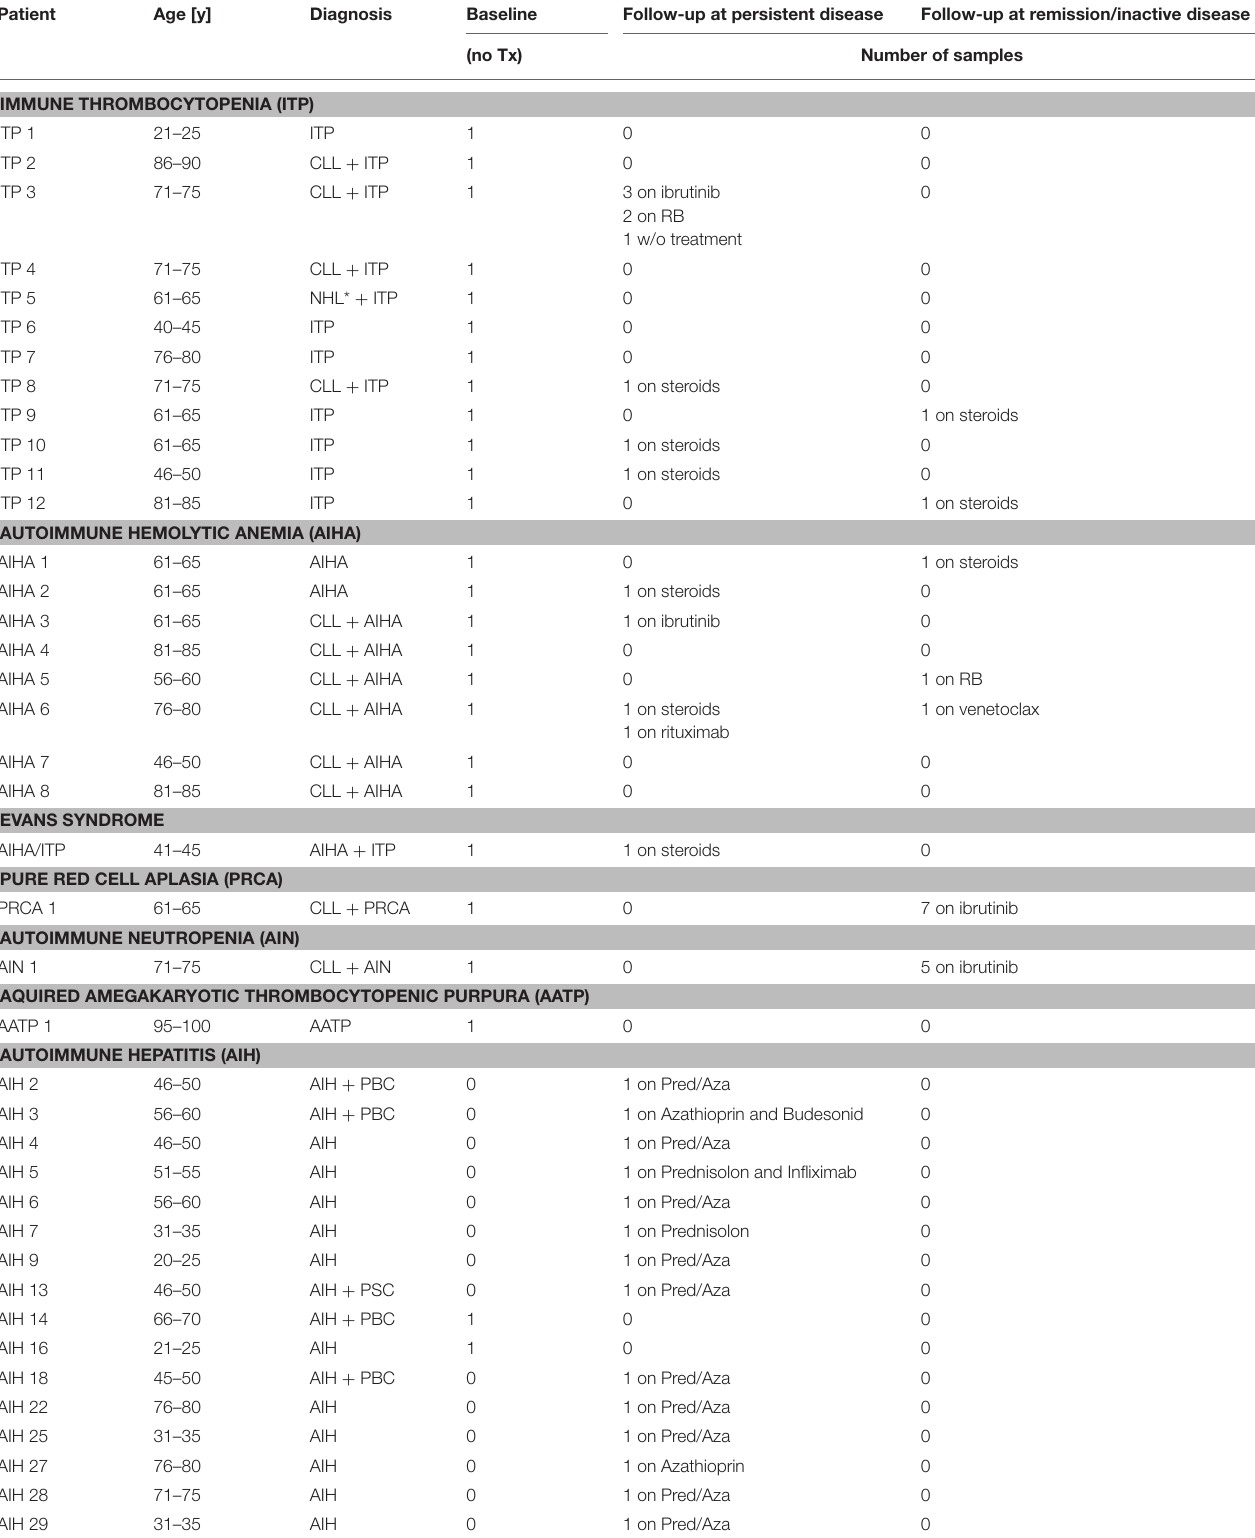
TABLE 1 | Patient and sample